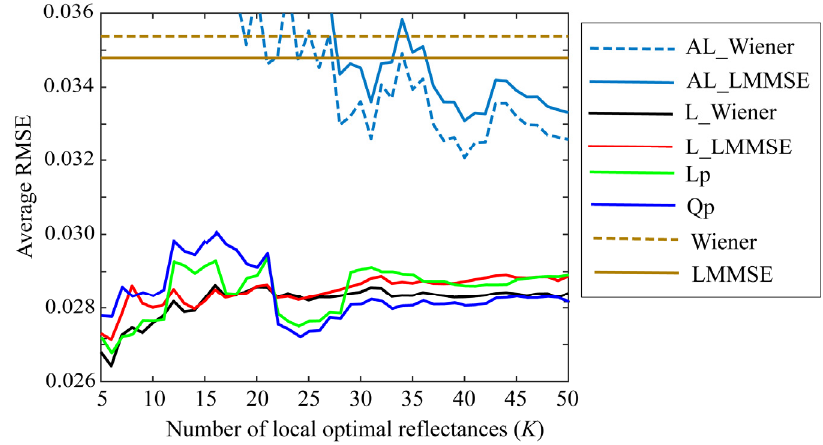
Figure 12. Average RMSEs yielded by the previous method compared with results obtained using the proposed method shown in Figure 6, when using iPhone 6s. Bold and broken cyan curves represent the previous method based on x all − x i ; AL_Wiener (AL_LMMSE) represents the adaptive local Wiener (LMMSE), where x all was calculated using the original Wiener (LMMSE), and then the best estimates ˆ x based on the selected dataset, L_Wiener, L_LMMSE, Lp, and Qp were calculated using the methods in Sections 4.1–4.4.